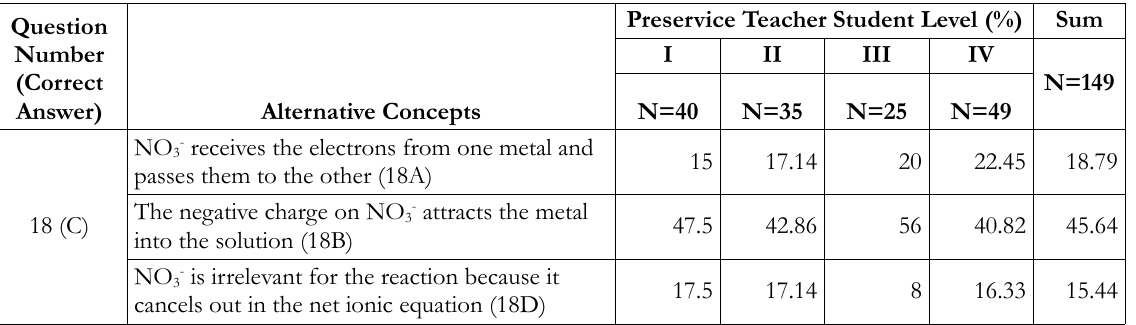
Table 8. Percentage of Alternative Concepts of Preservice Chemistry Teachers on Redox Concepts on Single Item